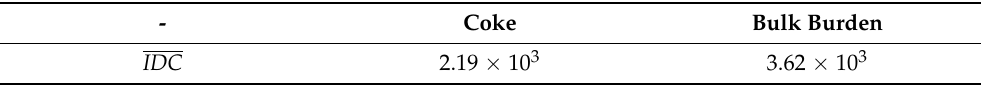
Table 3. Inertial drag coefficient of coke and bulk burden.